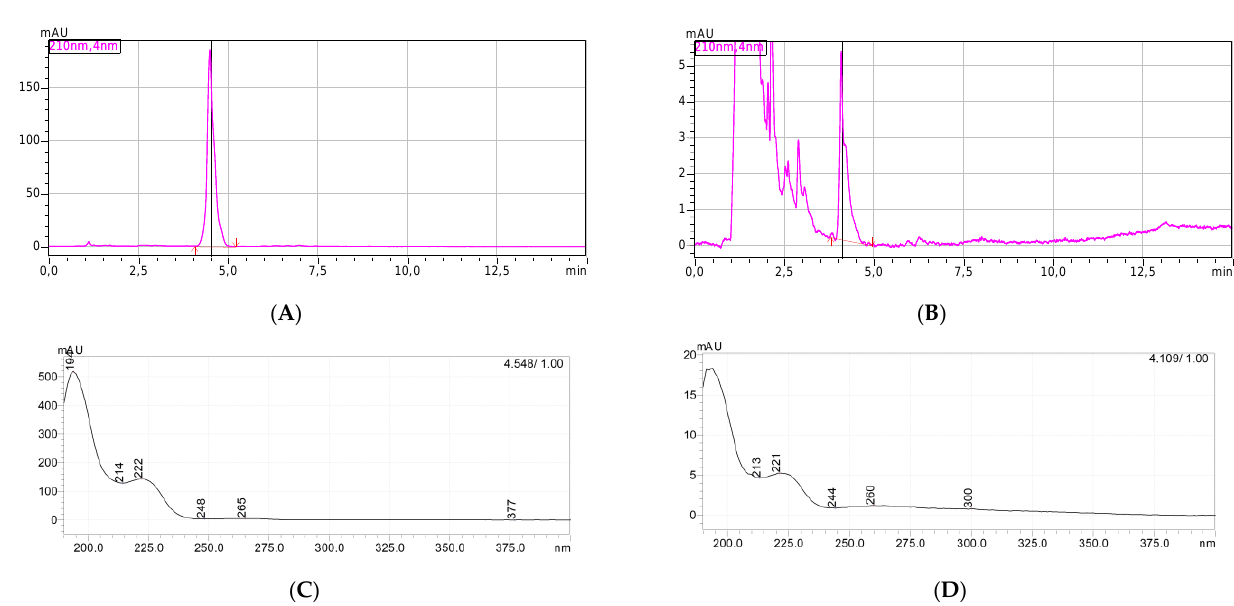
Figure 8. HPLC chromatograms ( A , B ) and UV–Vis spectra ( C , D ) of [ValOAm][IBU] (reference, at ( A , C )) and in the test ves-sel after 28 days of biodegradation at ( B , D ).